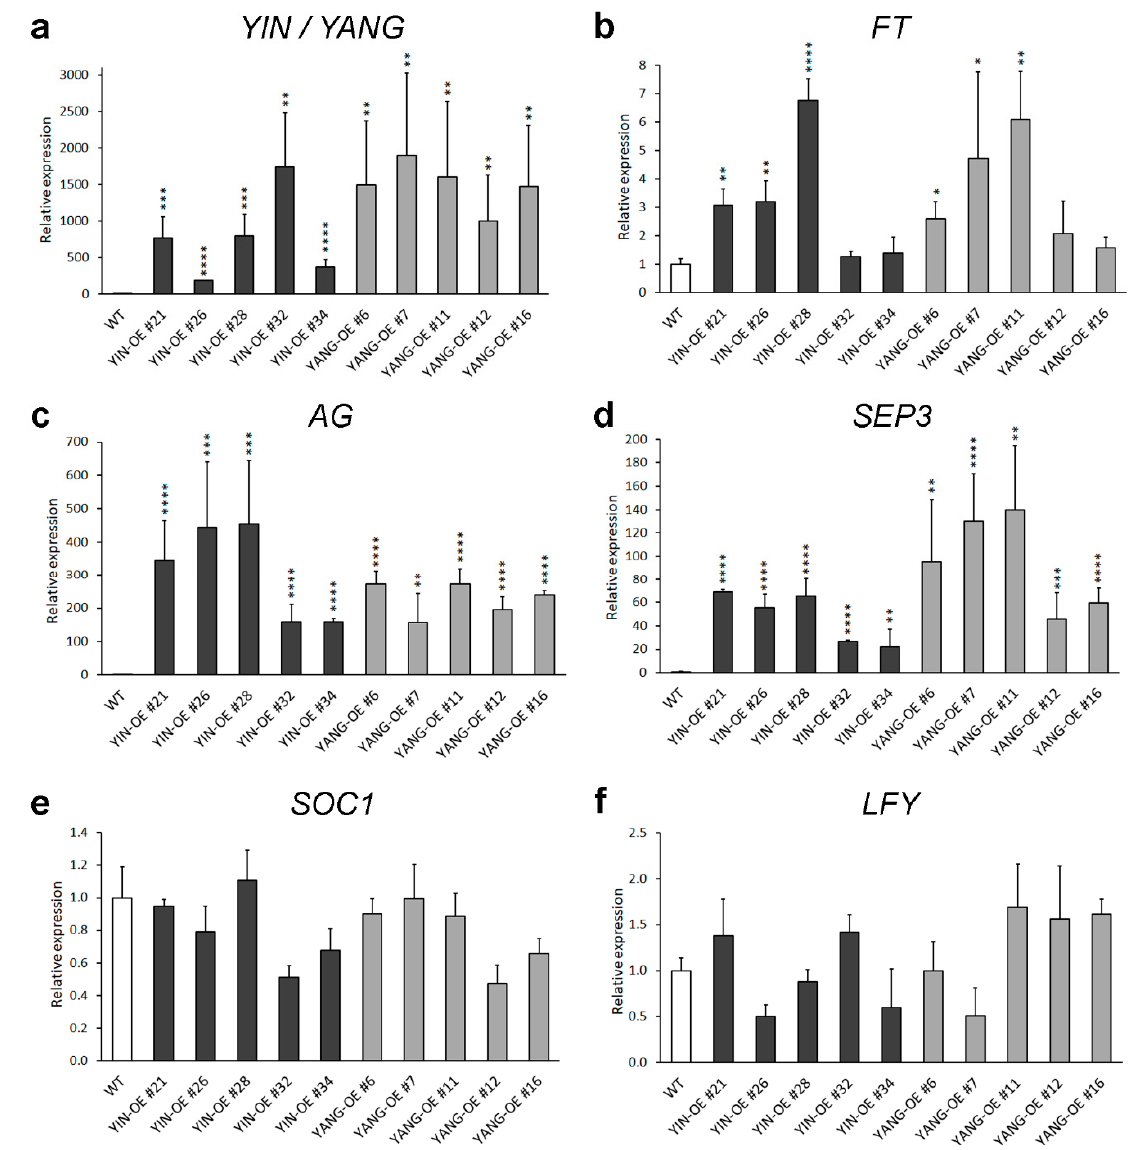
Figure 6. Relative gene expression of YIN and YANG ( a ) and endogenous flowering-related genes ( b – f ) in 14-day-old seedlings of Arabidopsis wild-type (WT, Col-0) and transgenic lines ( YIN_OE and YANG_OE ). Dark-gray bars represent independent YIN_OE lines (#21, #26, #28, #32, and #34); light-gray bars represent independent YIN_OE lines (#6, #7, #11, #12, and #16). The RT-qPCR data represent the mean ± standard error (SE) from at least two biological replicates per transgenic line (N ≥ 2), and ten biological replicates for Col-0 (N = 10). eIF4A1 was used as internal control, and the